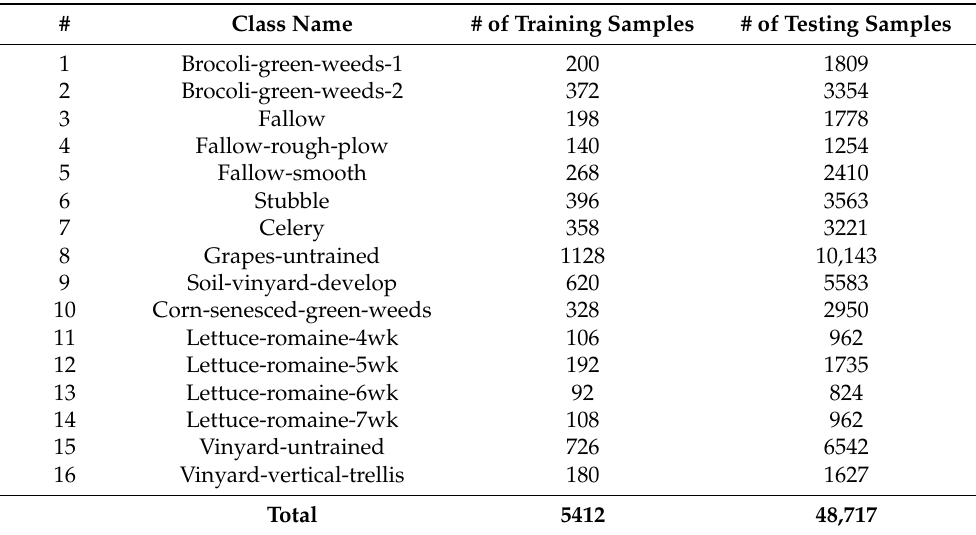
Table 1. Total number of class-specific training and testing samples used for Salinas dataset with 10% of training data.